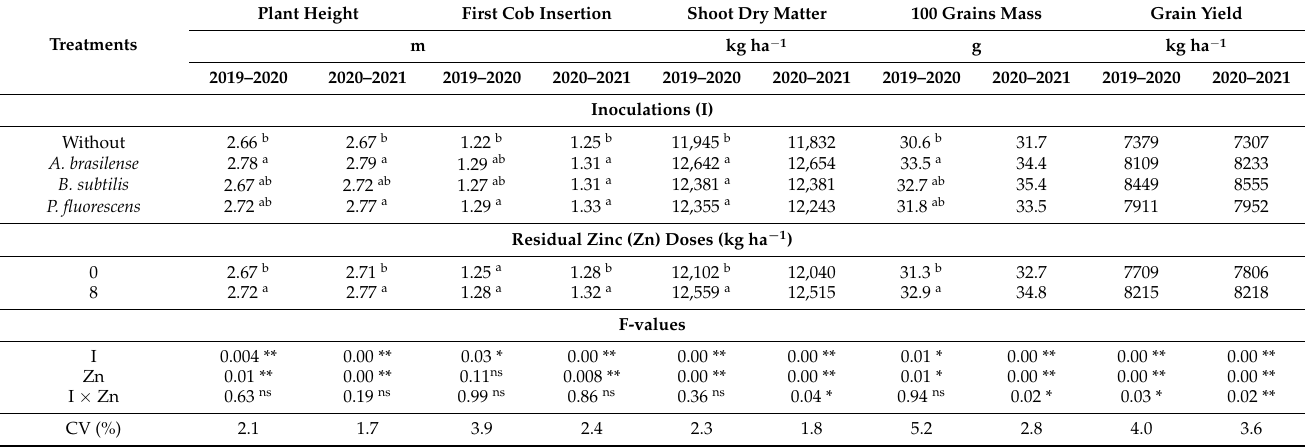
Table 1. First productive cob insertion, plant height, shoot dry matter, and grain yield of maize as influenced by diazotrophic bacteria and residual zinc doses in 2019–2020 and 2020–2021 cropping